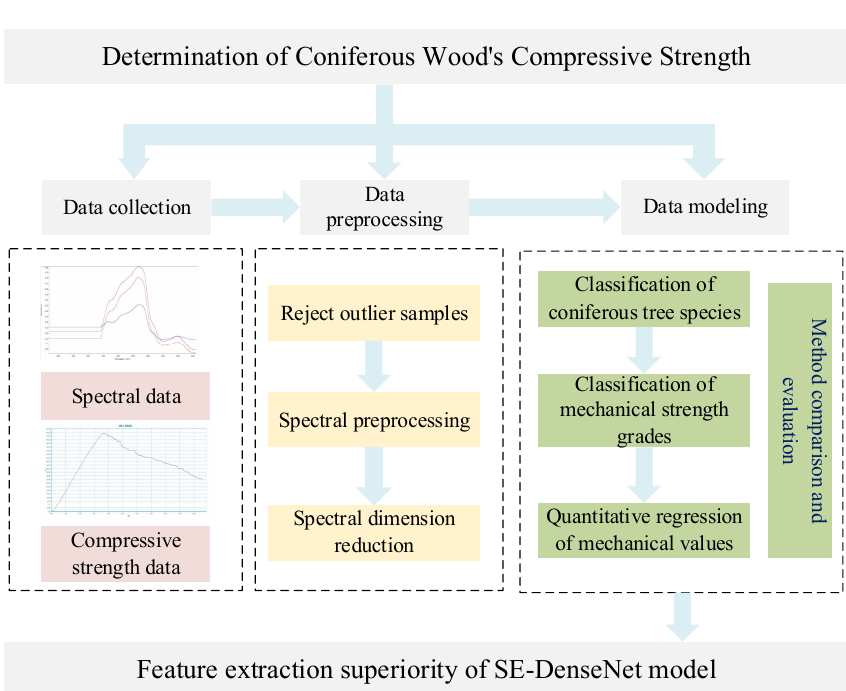
Figure 2. Technology